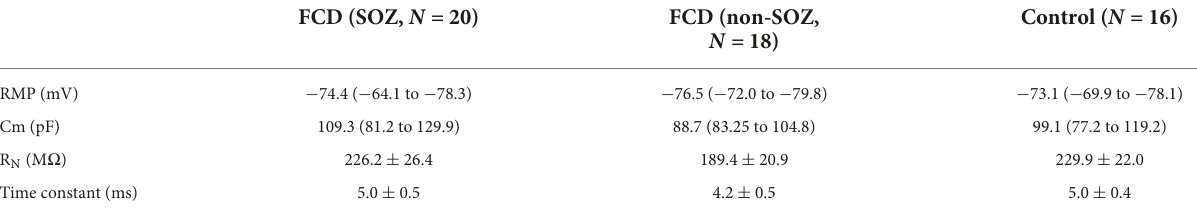
TABLE 2 Comparison of the intrinsic membrane properties of pyramidal neurons among different groups.